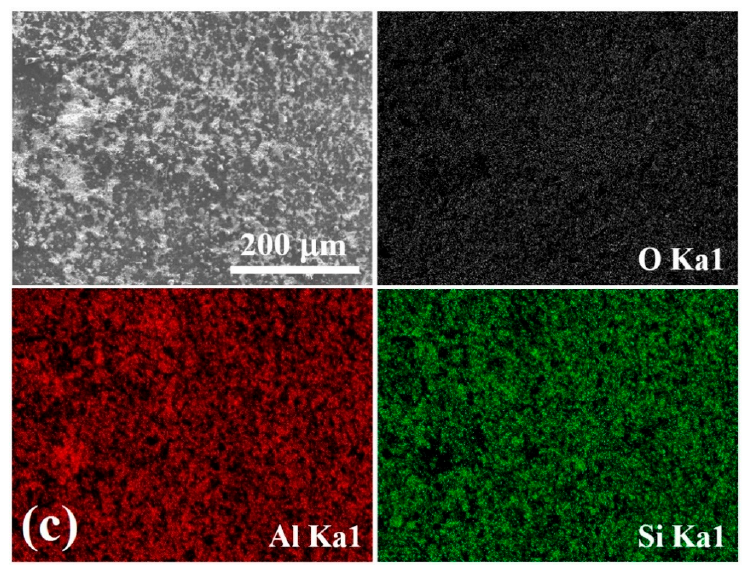
Figure 5. Typical SEM micrographs taken from the sample surface coated with 15 μ m SiO 2 powders for ( a ) 1 cycle; ( b ) 2 cycles; and ( c ) 3 cycles of UMCA, with the EDS mapping. The Si atoms occupy about from 30% to 60% area fraction of the whole analyzed area.